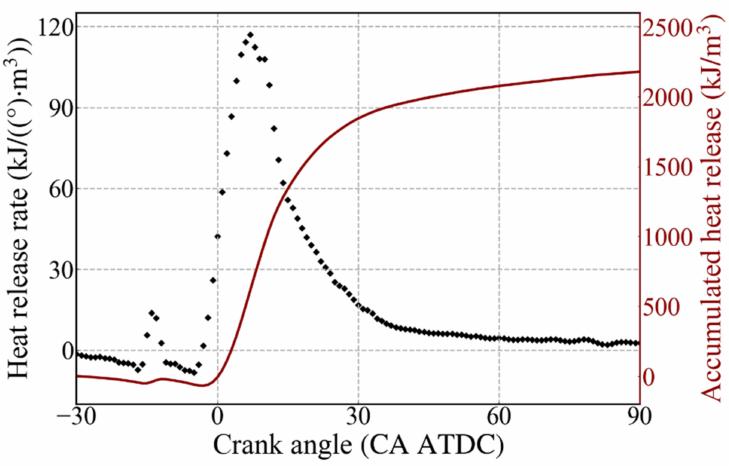
Figure 3. Heat Release Rate and Accumulated Heat